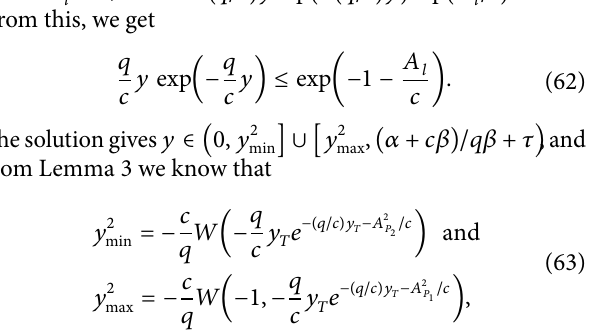
∗ , 푦 = 0.6798 , , 푝 = 0.8 훿 = 0.3